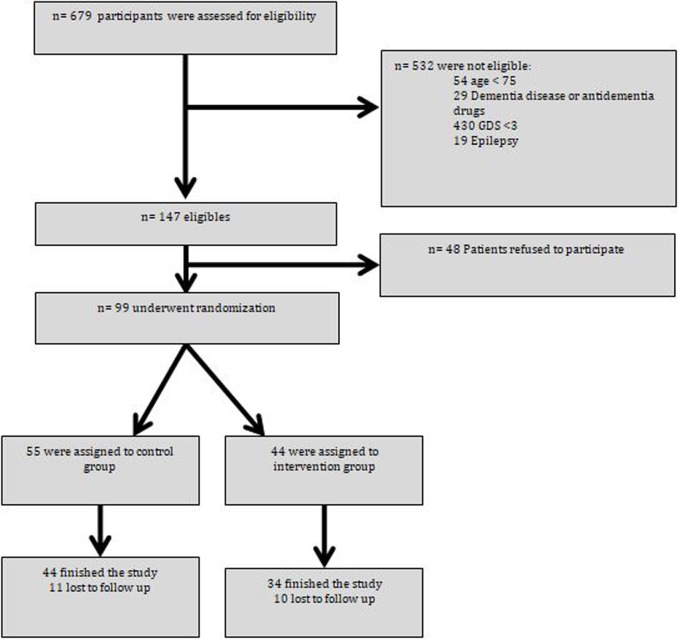
Flow chart of participants.